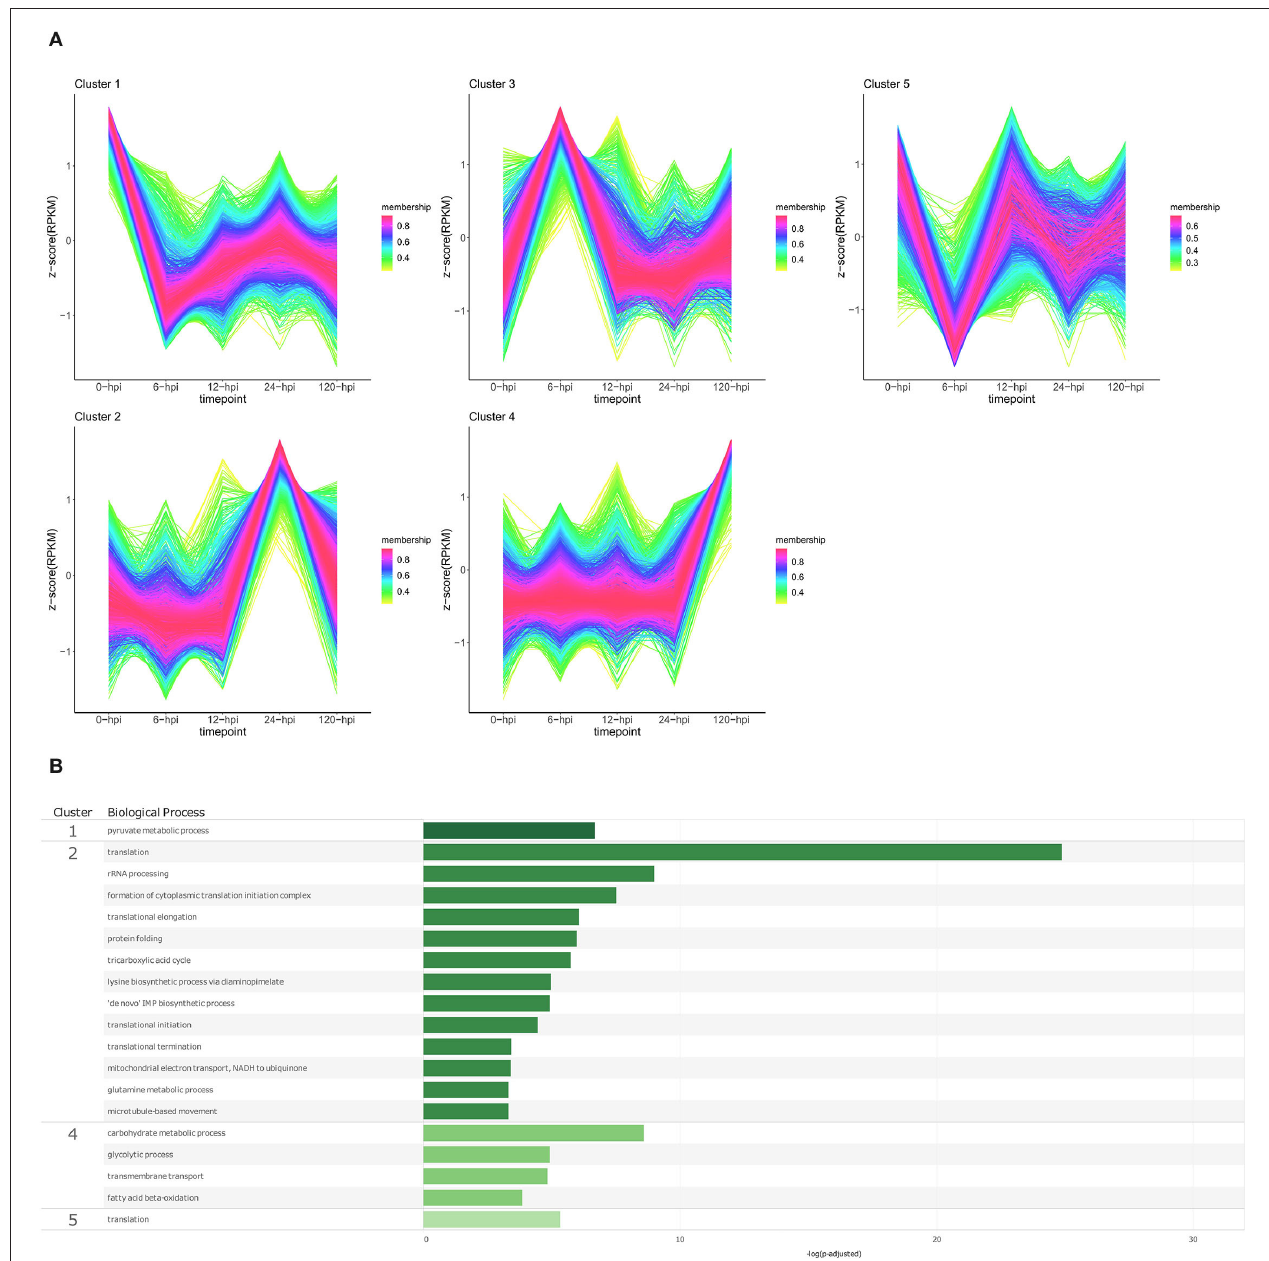
FIGURE 7 | Temporal clustering and Gene Ontology enrichment of Phytophthora cinnamomi differentially expressed genes (DEGs) following inoculation of the Persea americana rootstock R0.12. (A) Sample libraries from in vitro mycelial controls and the susceptible P. americana rootstock R0.12 inoculated with P. cinnamomi were used in clustering analyses. DEG Z-scores, based on reads per kilobase million (RPKM) normalized read counts, were calculated and used for clustering analyses using the fuzzy c-means (Futschik and Carlisle, 2005) in the R package TCseqv1.16.0 (Wu and Gu, 2021). Inoculated samples included 6, 12, 24, and 120h post inoculation (hpi) and are indicated on the x-axis, with the mock-inoculated samples indicated as 0 hpi. Membership scores produced by the fuzzy c-means algorithm are color-coded and indicated to the right of each cluster. (B) Member genes from each cluster were subjected to gene ontology (GO) enrichment, and significantly overrepresented GO terms, with adjusted p -value < 0.05 Benjamini-Hochberg false discovery rate, were reduced in REVIGO (Supek et al., 2011). The cluster from which the terms originate is indicated on the left most side of the Figure, followed by the biological process GO term. The overrepresented p -value of each GO term is indicated along the x-axis as –log 10 ( p